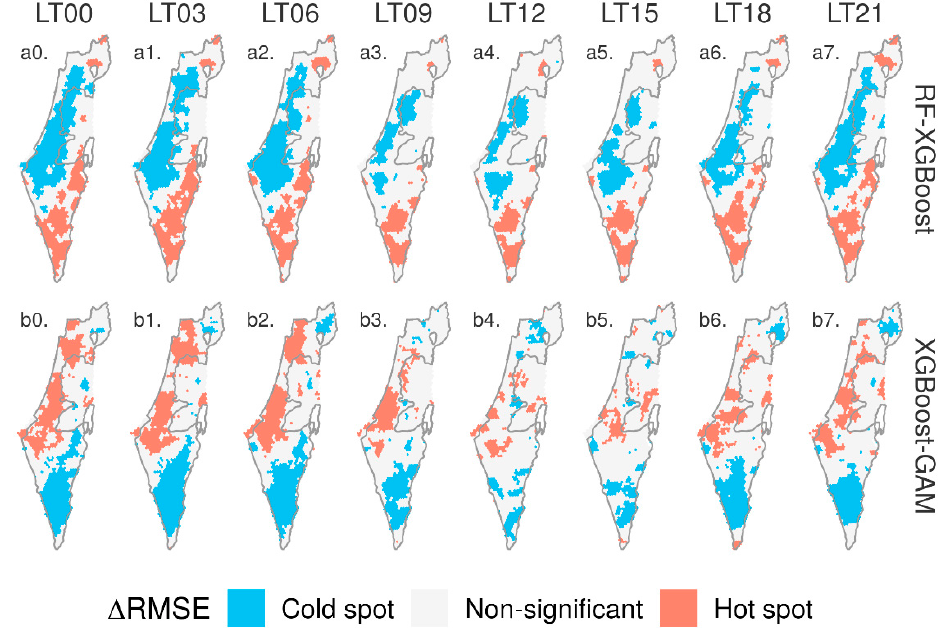
Figure 8. Hot and cold spots of performance difference (disaggregated by hour but shown at 3-h intervals) between pairs of models (RF—XGBoost ( a0 – a7 ), and XGBoost—GAM ( b0 – b7 )) in Stage 1 based on Getis-Ord Gi* statistics.